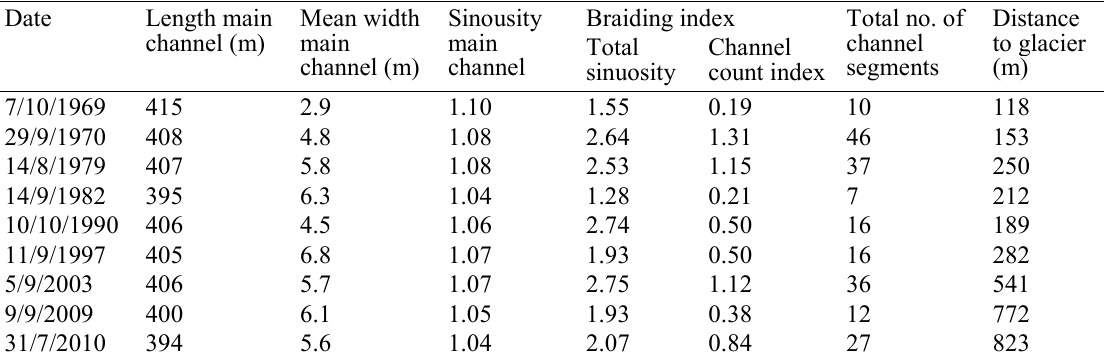
Table 2 Results of the channel planform analyses.